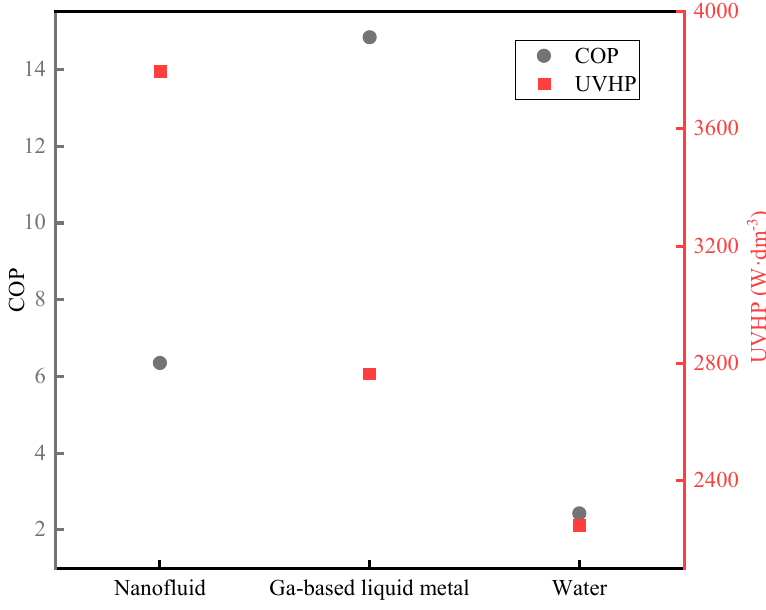
Figure 8. COP and UVHP of di ff erent fl uids at the temperature span of 10